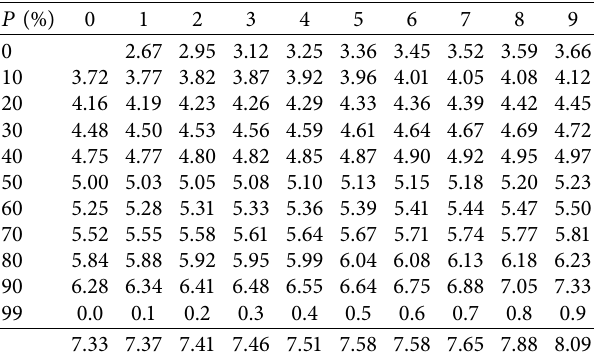
Table 3: Conversion between probability and death